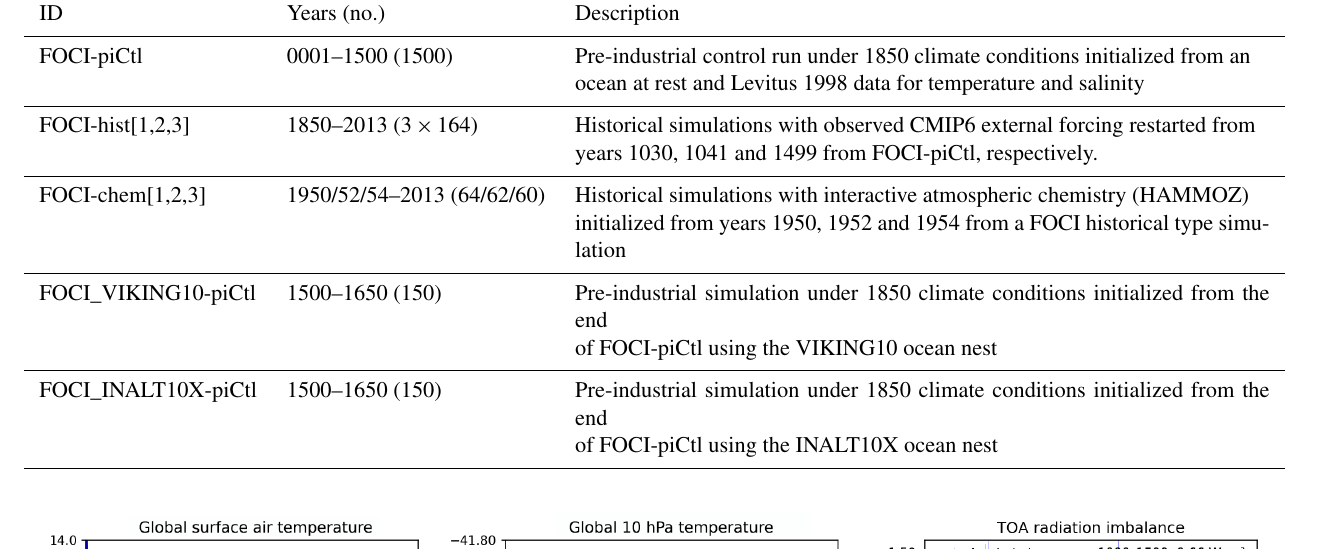
Table 2. Overview of FOCI simulations.